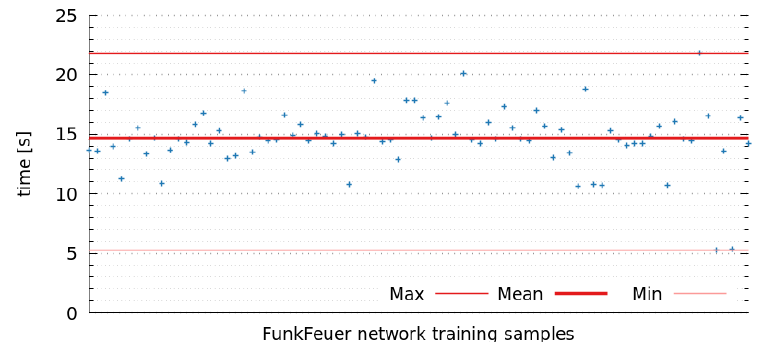
Figure 18. Execution time for Training WEKA model: mean is 14.68 s, maximum is 21.79 s and minimum is 5.31